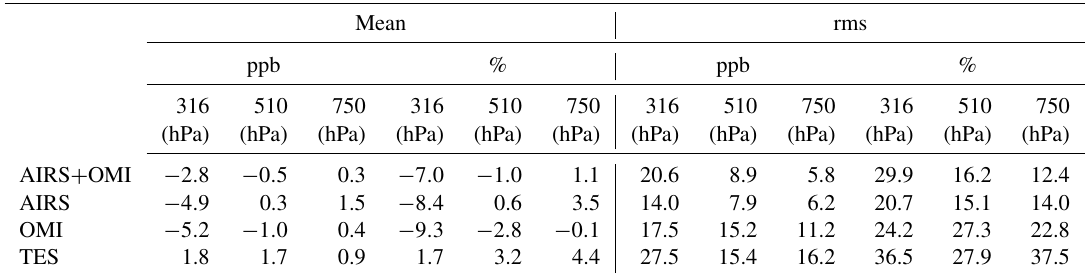
Table 5. Comparisons between satellite remote-sensing and ozonesonde in situ measurements for 2006 at three pressure levels (316, 510, and 750hPa), without the satellite observation operators applied to the ozonesonde